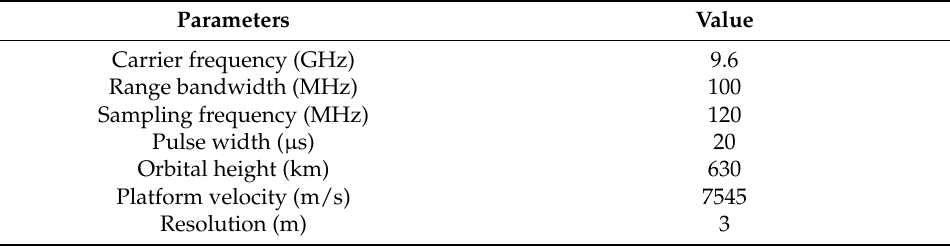
Table 2. System parameters for Sat-1 and